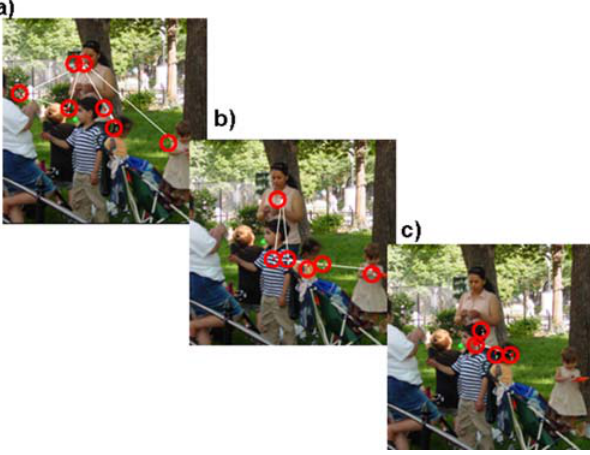
Figure 1. Example of eye movement patterns. An example of eye movements from three participants. (a) A participant viewing a new scene. (b) A participant viewing a scene for the second time and classifying it as ‘‘known’’. (c) A participant viewing the scene for a second time and classifying it as ‘‘remembered’’. The examples demonstrate fewer and more clustered fixations (smaller inter-fixation distance) for ‘‘remembered’’ photos than ‘‘known’’ photos and new photos. doi:10.1371/journal.pone.0002884.g001 PLoS ONE |